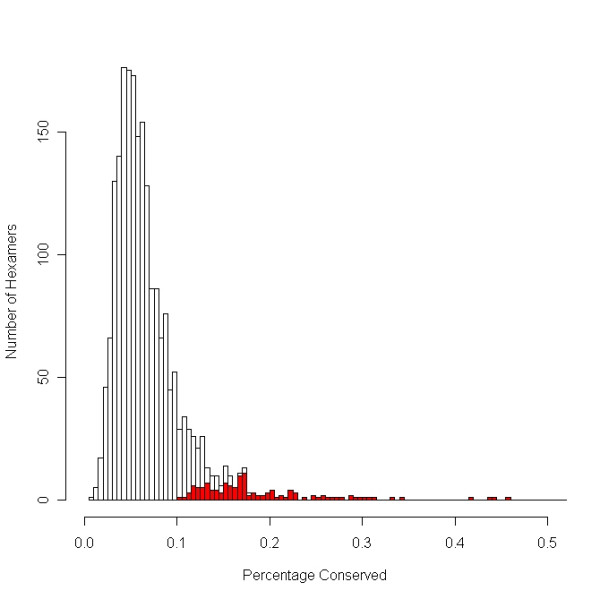
Histogram of percentage of significantly conserved occurrences for each hexamer. Hexamers with an unexpectedly high fraction (χ2 ≥ 10.828, P ≤ 0.001) of conserved instances are shown in red.